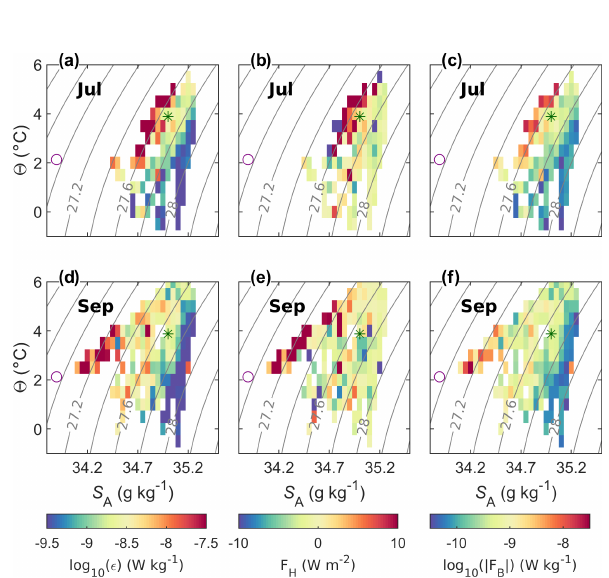
Figure 5. θ – S A diagrams where the color-coded bins are dissipation rate (a, d) , turbulent heat flux (b, e) and magnitude of buoyancy flux ( c, f ; the buoyancy fluxes are all oriented downward). Contours are σ 0 , referenced to surface pressure. Panels (a) , (b) and (c) are for summer (July cruise) and (d) , (e) and (f) for fall (September cruise). The green star is the mean temperature and salinity property of the mixed layer in July and the purple circle is the corresponding value in